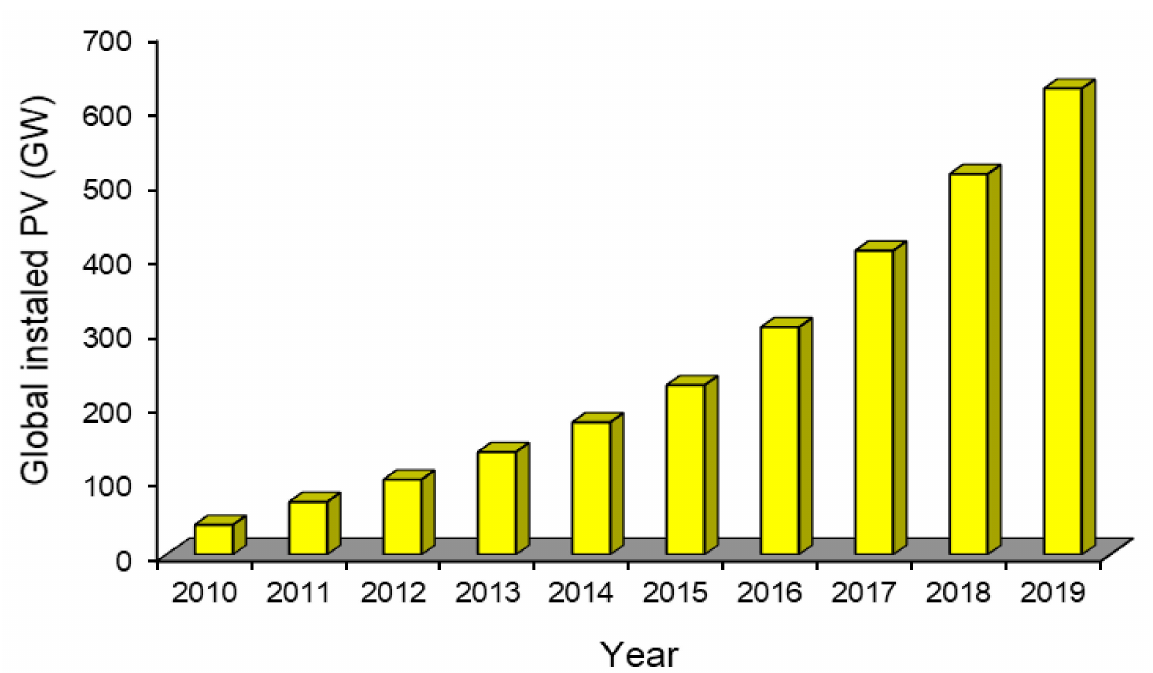
Figure 3. Global installed solar cell capacity (GW) in 2009–2019. Own elaboration based on data from [63].